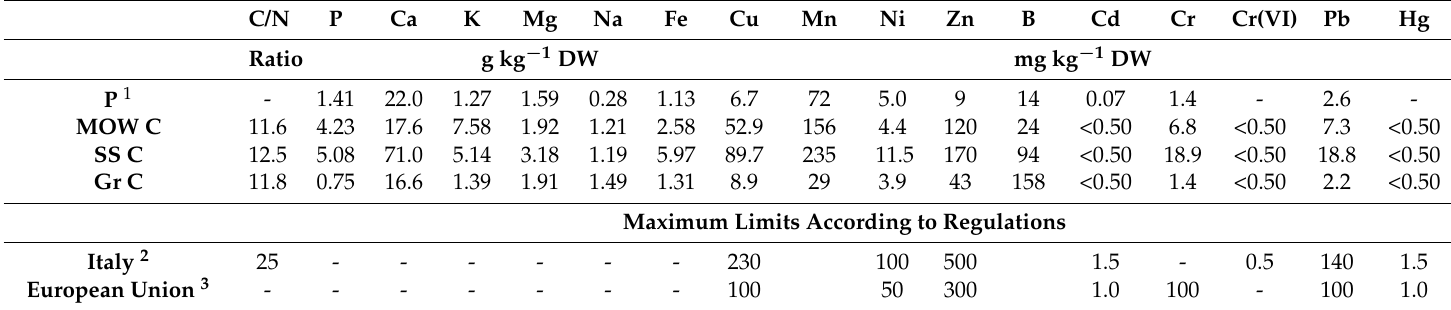
Table 1. Main chemical features of the materials used for the preparation of the growing media